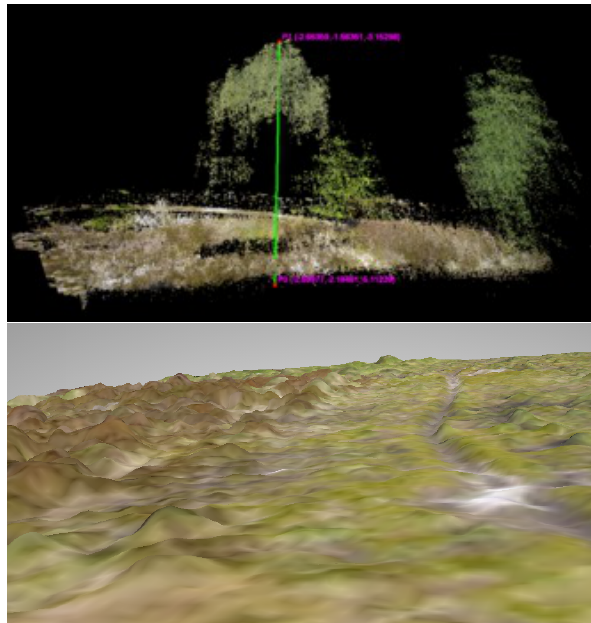
Figure 12: Stereo reconstruction. Top: 3D cloud points from the stereo couple used for dendrometric measures (courtesy of B. Petitpas). Bottom: 3D mesh from stereo allow the identification of overground structures (here, low bushes of